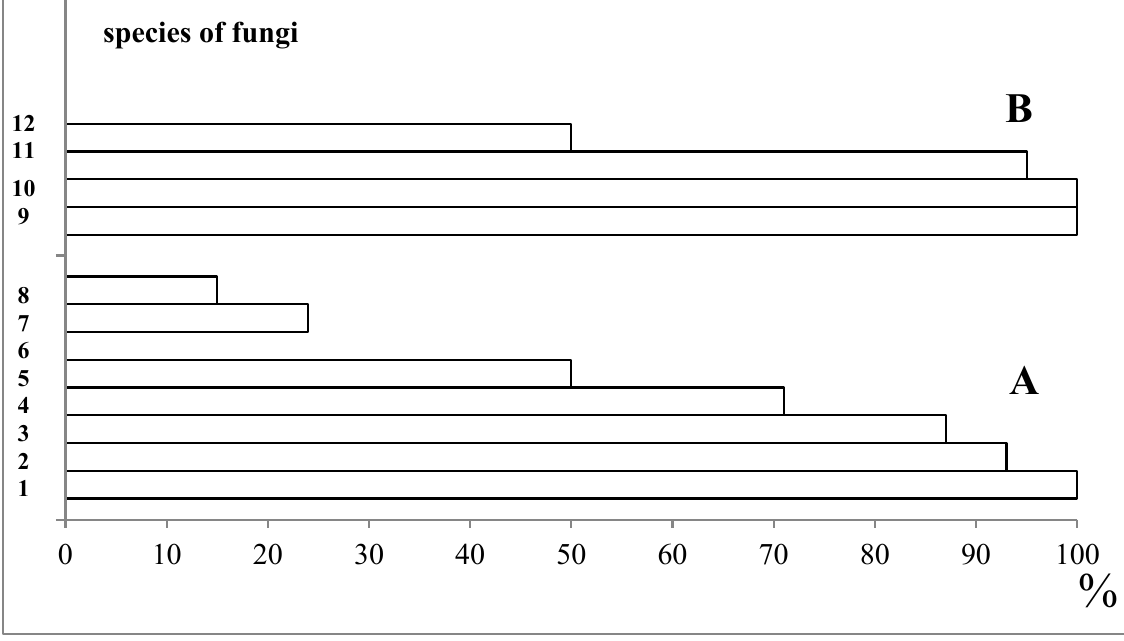
Figure 3. Share (w%) of dominant species in the genus structure; ( A )—filamentous fungi, ( B )—yeasts; (1) Trichoderma viride , (2) Phoma herbarum , (3) Geotrichum candidum , (4) Aspergillus fumigatus , (5) Fusarium solani , (6) Penicillium expansum , (7) P. verrucosum , (8) P. chrysogenum , (9) Saccharomyces cerevisiae, (10) Trichosporon beigelii , (11) Rhodotorula rubra , (12) Candida guilliermondii